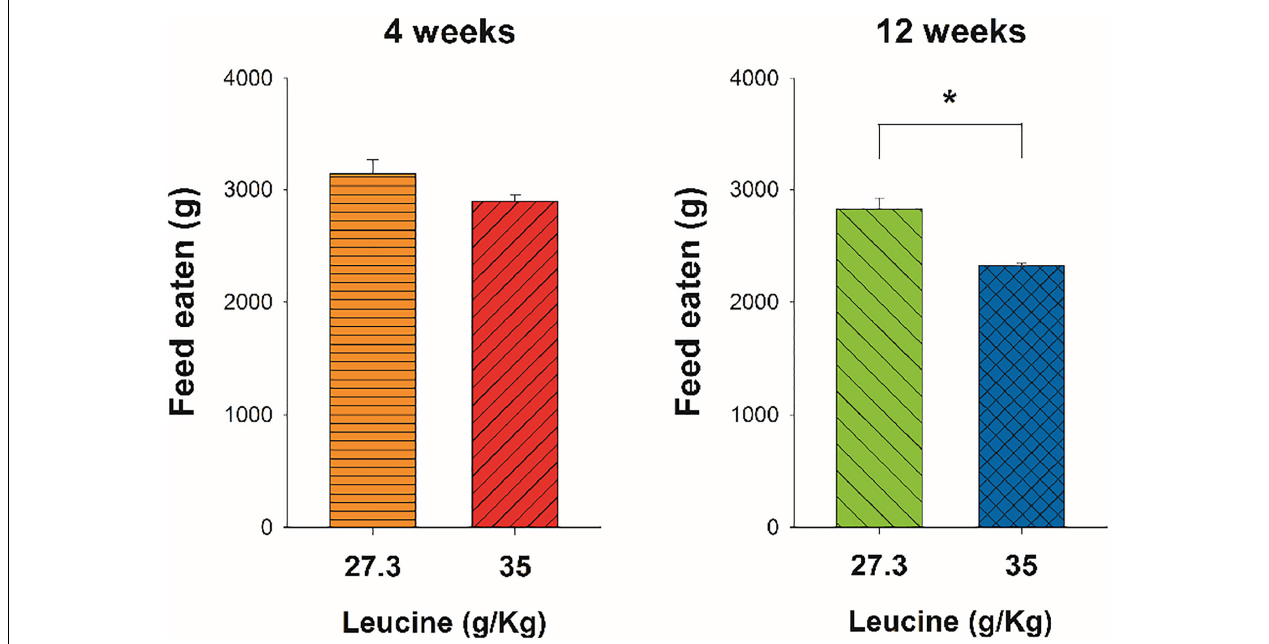
FIGURE 5 | Food intake of Atlantic salmon after four (4w) or twelve (12w) weeks of feeding with control leucine diet (CL; 27.3 g/kg) or high leucine diet (HL; 35 g/kg). Results are shown as the mean + S.E.M. of the data obtained during the 7 days before the sampling points at week 4 and week 12. *Significantly different ( p < 0.05) between